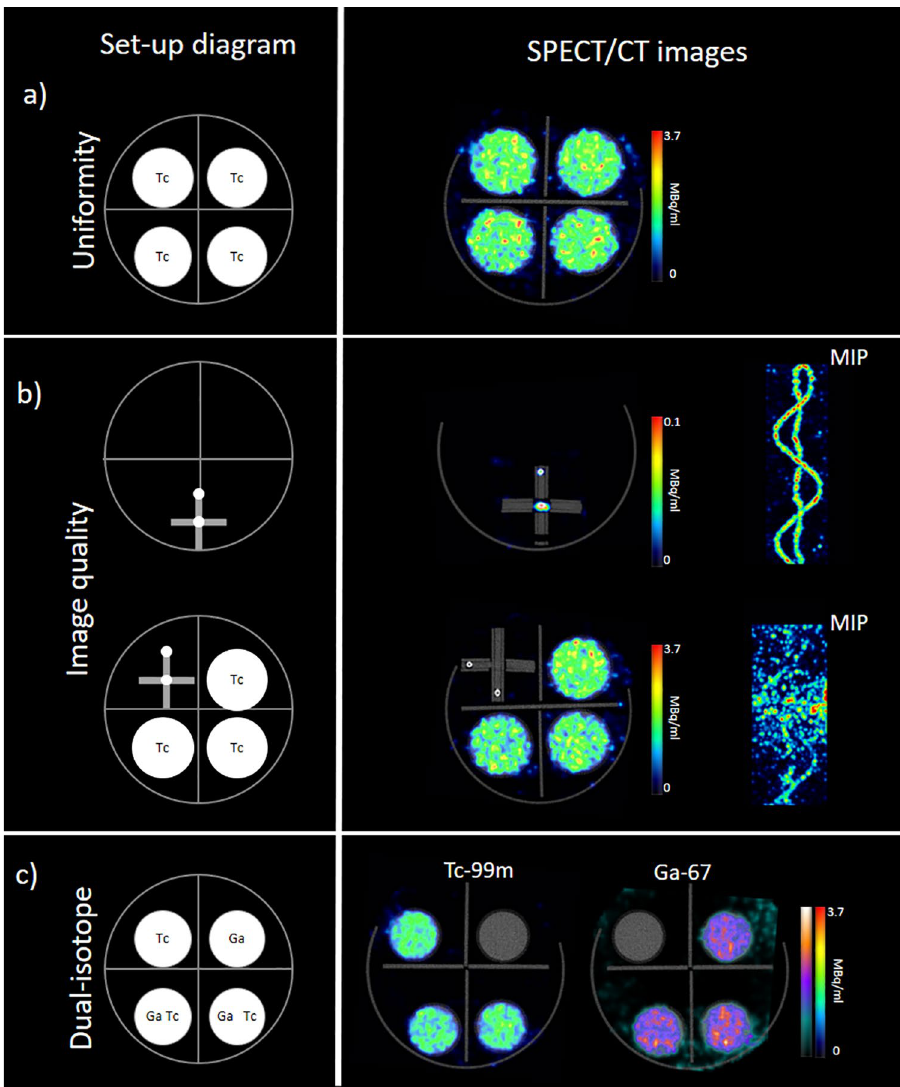
Figure 4. SPECT/CT images obtained with the multi-bed device and the UHR-RM collimator. The first column shows a schematic representation of the experimental set-up. ( a ) SPECT axial slice of four uniform syringes, ( b ) Sinusoidal phantom acquired alone and with three uniform syringes. Fused SPECT/CT axial slices and MIP reconstructions are shown. ( c ) Syringes with 67 Ga and 99m Tc for multi-isotope performance evaluation. Fused SPECT/CT images reconstructed for each radionuclide are